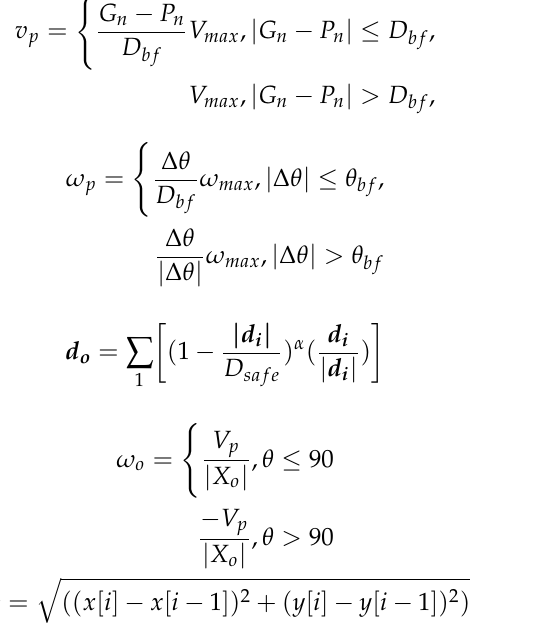
Algorithm 2. The robot’s linear velocity v p is controlled by satisfying Equation (1). ω p is